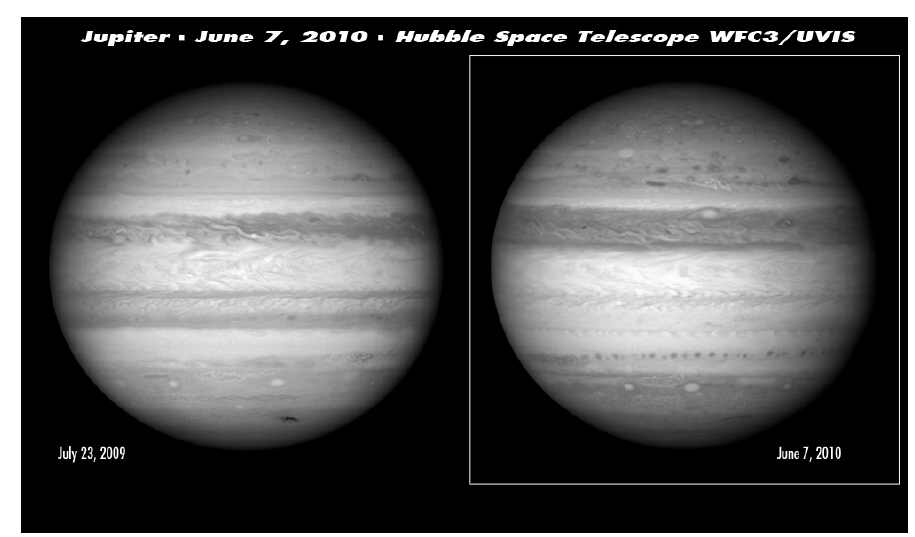
Fig. 1. Images of Jupiter from the Hubble Space Telescope showing the 2010 disap- pearance of its South Equatorial Belt. Credit: